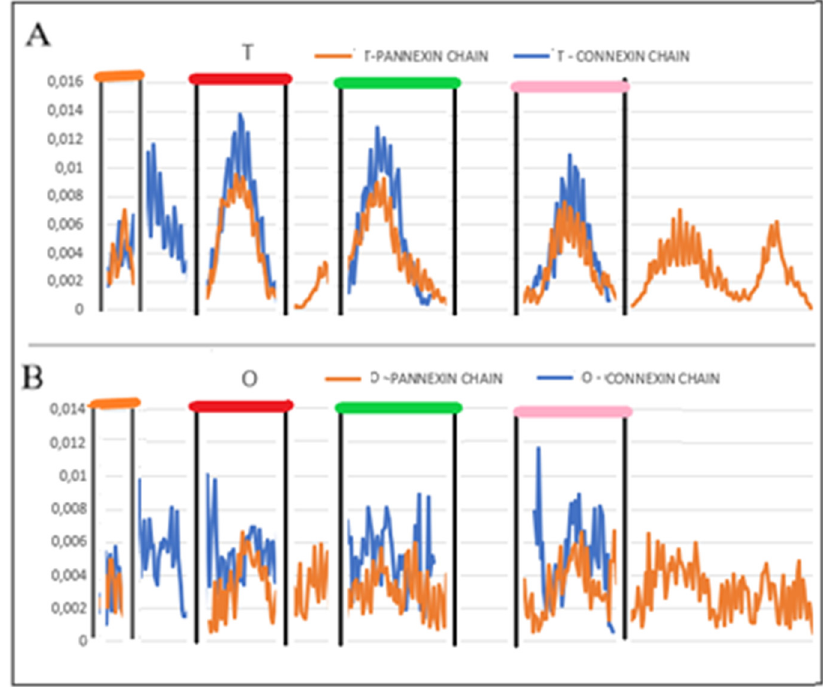
Figure 5. Summary of profiles for identification of analogous segments in pannexin (red) and connexin chains (blue) ( A )—T; ( B )—O; for chains treated as individual structural units pannexin (blue) and connexin (orange) and sections identified as analogous in the structure of single chains—identification based on the T profile. The colors differentiate the fragments as shown also in Figure 6 and Table 2.